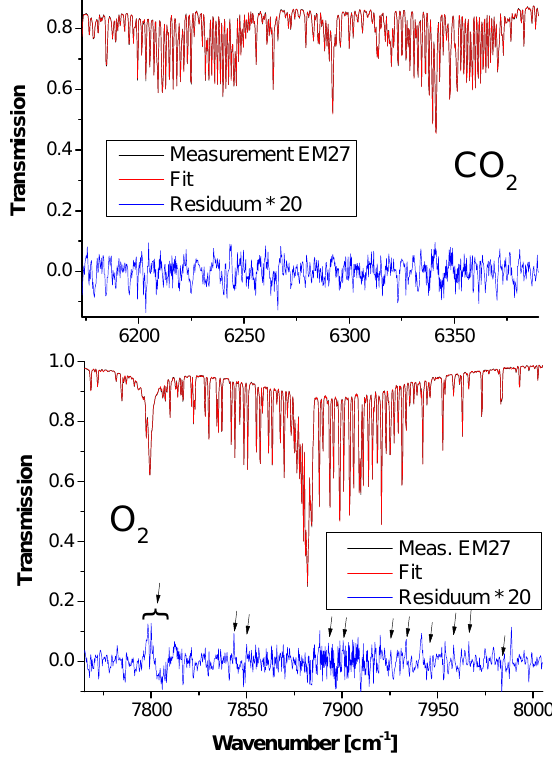
Fig. 5. Spectral windows used by PROFFIT to derive the CO 2 and O 2 columns. In the lower figure the systematically occurring resid- uals due to deficiencies of the solar line modelling are marked in the